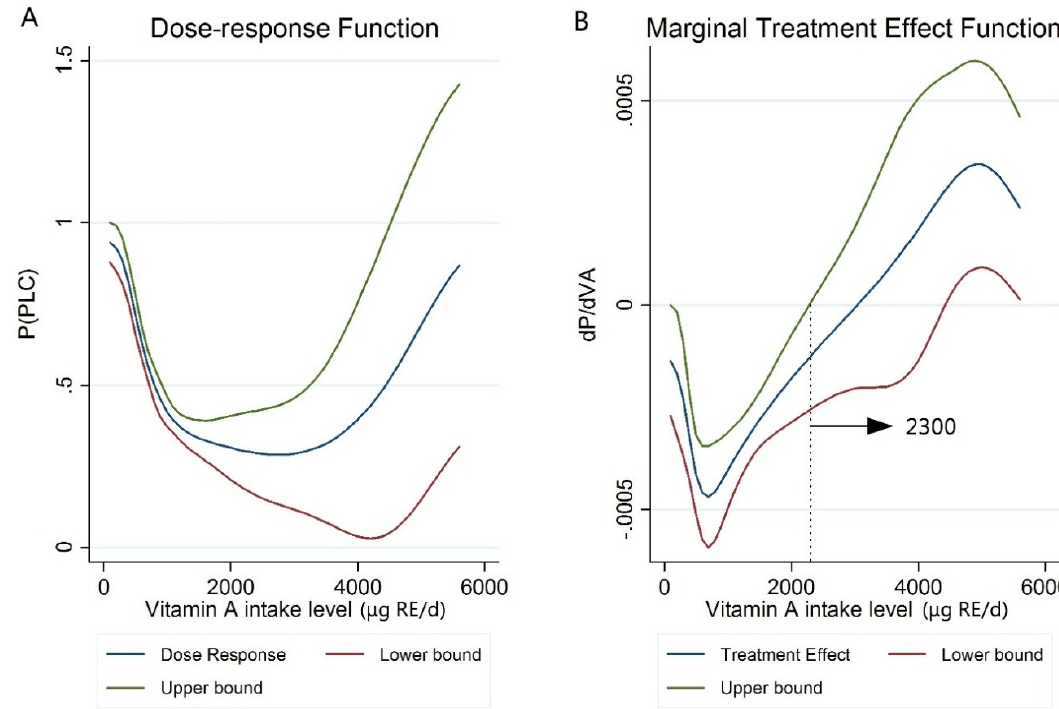
Figure 1. Dose–response function and marginal treatment effect function (dP/dVA) of expected probability of PLC and vitamin A intake (in µ g retinol equivalent (RE)/day, 1 µ g RE = 3.3 IU) using the generalized propensity score (GPS) approach, point estimate, and 95% CI. ( A ) The relationship between VA intake and the expected probability of PLC; ( B ) marginal treatment effect function of VA intake and the expected probability of PLC association. Lower and upper bound: 95% confidence interval; P (PLC) = the expected probability of PLC; dP/dVA = the derivating dose–response function.